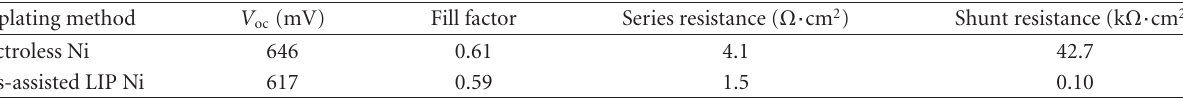
Table 3: Cell performance from light IV data.